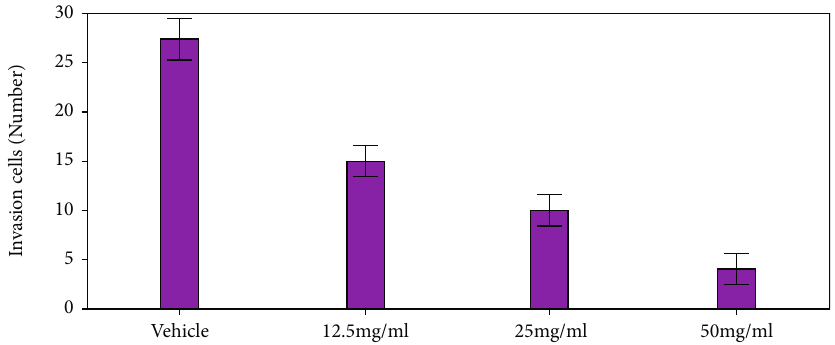
Figure 7: p < 0 : 05 when compared to vehicle exhibits HCT116 cell